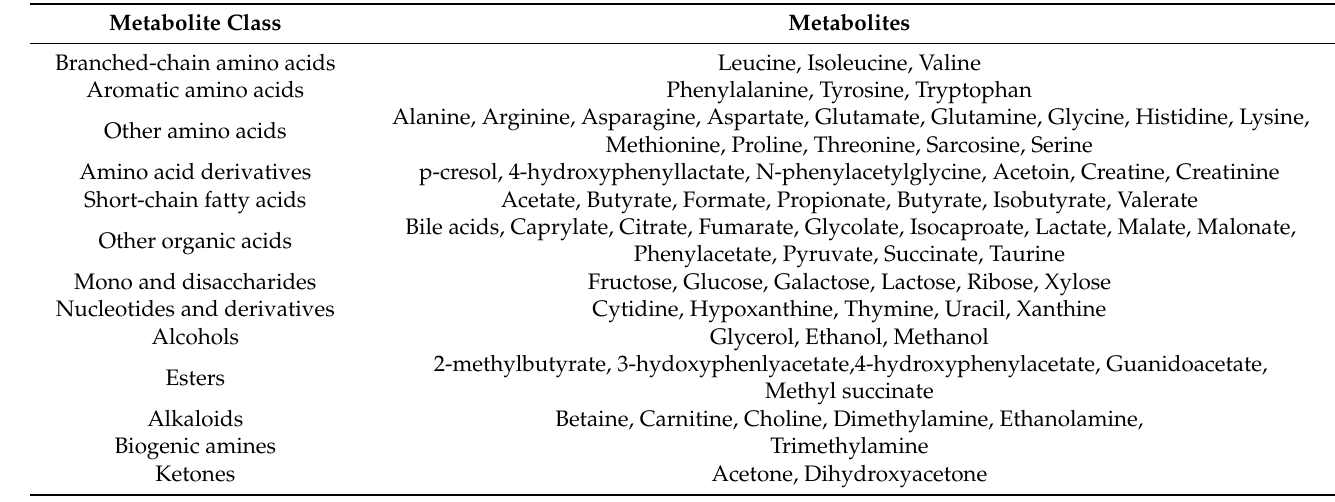
Table 1. Metabolite classes and metabolites in feces reported by NMR-based